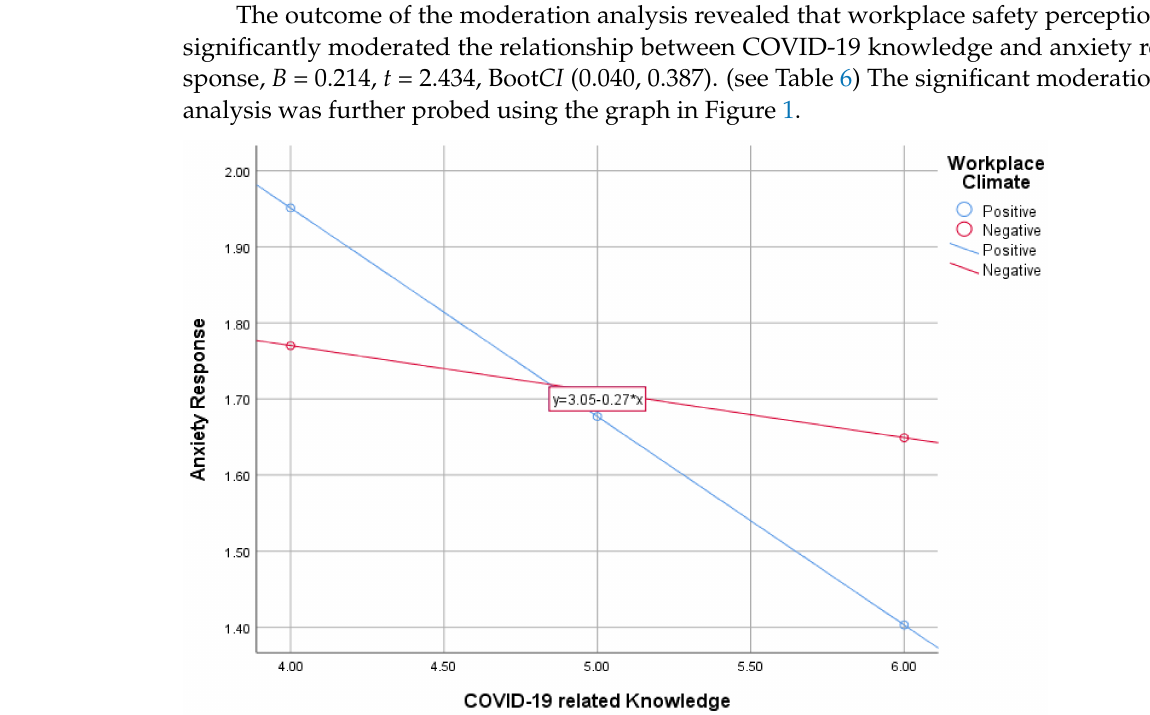
Figure 1. Probing graph on the moderating role of workplace safety perception in the link between COVID-19 knowledge and